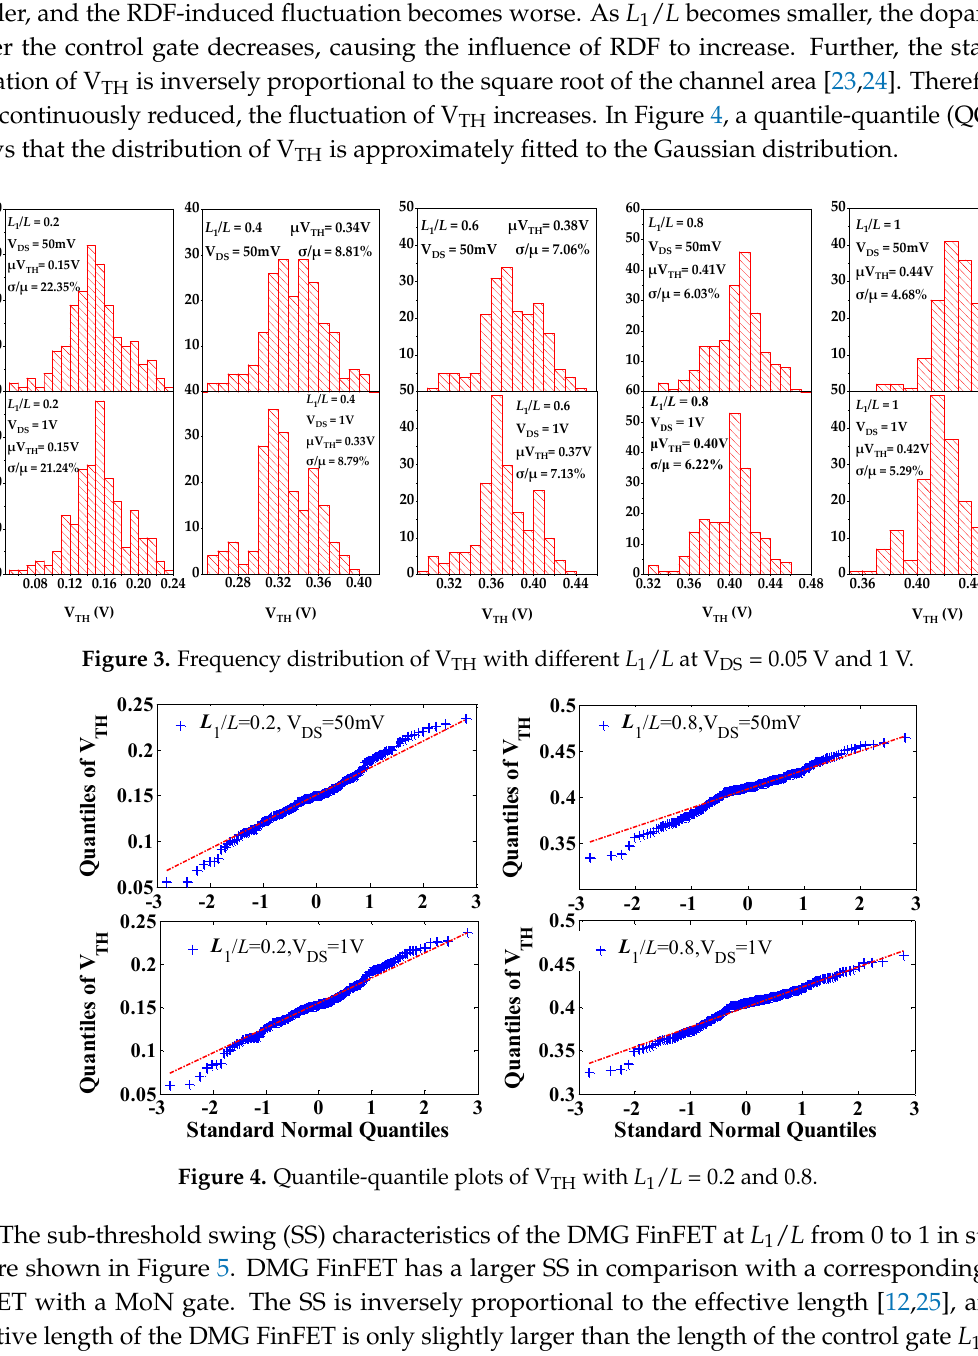
Figure 4. Quantile-quantile plots of V TH with L 1 / L = 0.2 and 0.8.